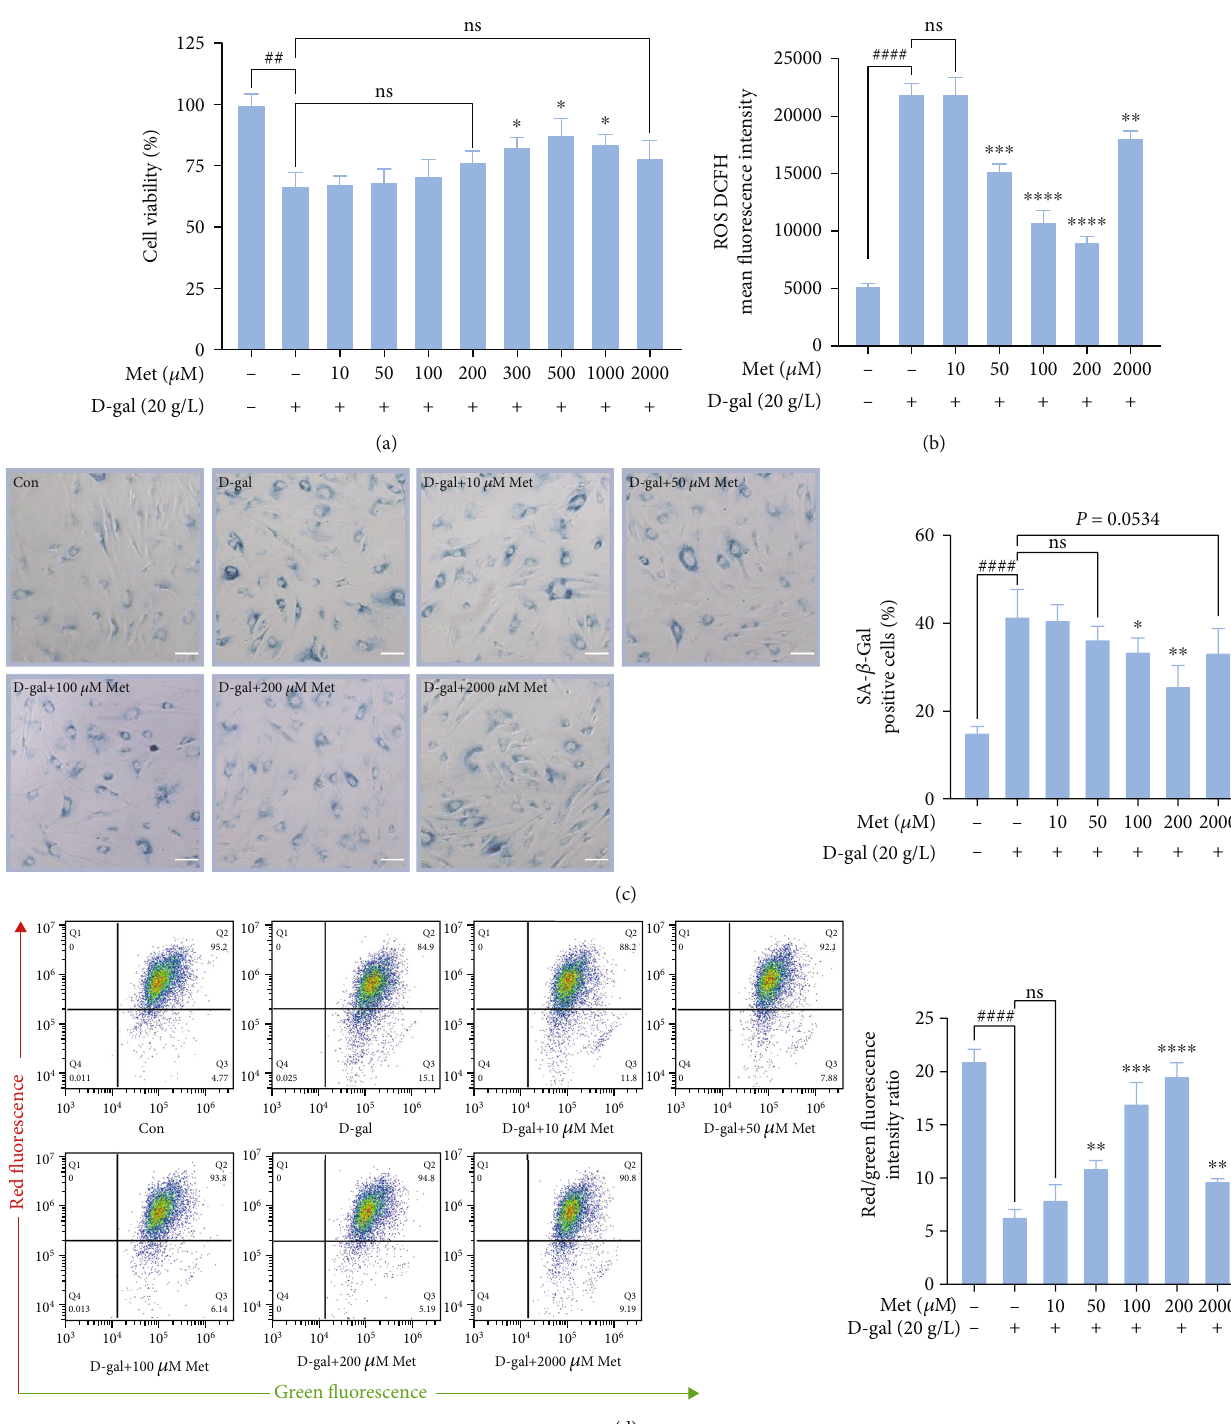
Figure 2: The e ff ects of metformin on improving senescence phenotypes of D-gal-induced hBMSCs. (a) The cell viability of hBMSCs was assessed by CCK8 assay after cultured for 72h. (b) Quanti fi cation of intracellular ROS levels by fl ow cytometry. (c) Representative images of SA- β -Gal-positive hBMSCs, scale bar, 100 μ m. (d) Quanti fi cation of MMP by fl ow cytometry. n = 3 for each group. Data shown are mean ± SEM . Two-tailed t test. ∗ p < 0 : 05 , ∗∗ p < 0 : 01 , ∗∗∗ p < 0 : 001 , and ∗∗∗∗ p < 0 : 0001 versus the D-gal group; ## p < 0 : 01 and #### p < 0 : 0001 versus the control group; ns: not signi fi